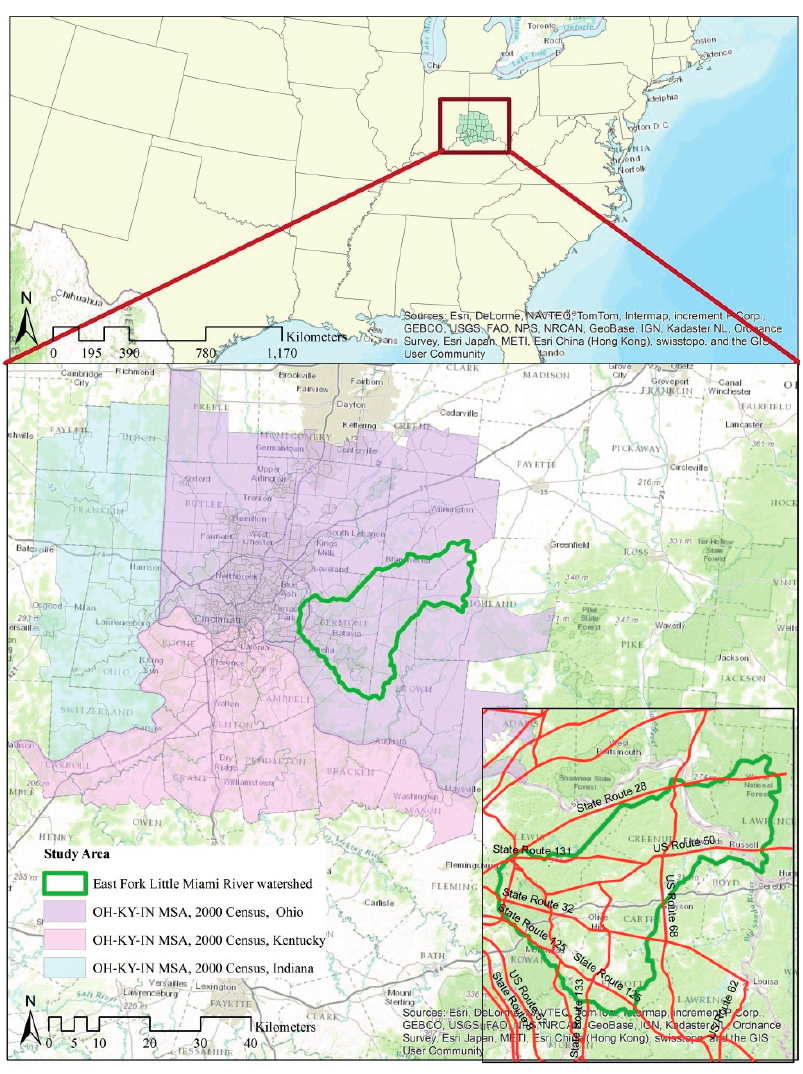
Figure 1. Location of the Cincinnati Middleton OH-KY-IN MSA and the East Fork Little Miami River (EFLMR)